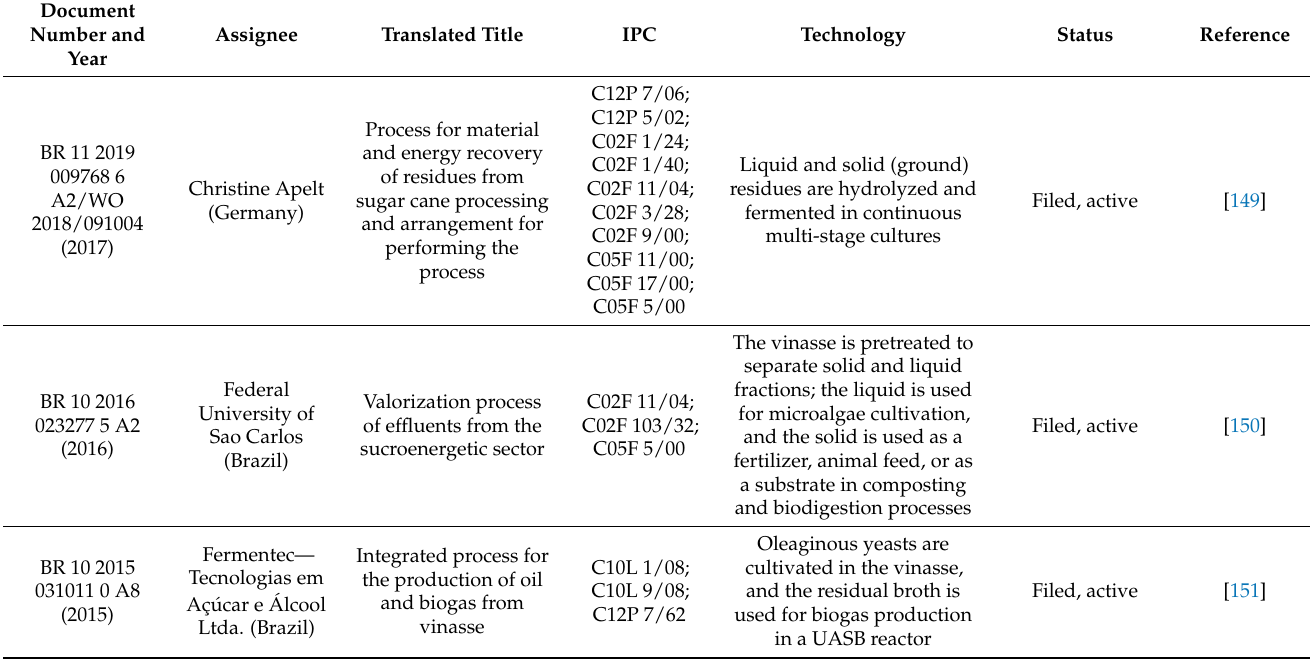
Table 3. Relevant patent documents retrieved from the Brazilian patent database (National Institute of Industrial Property,